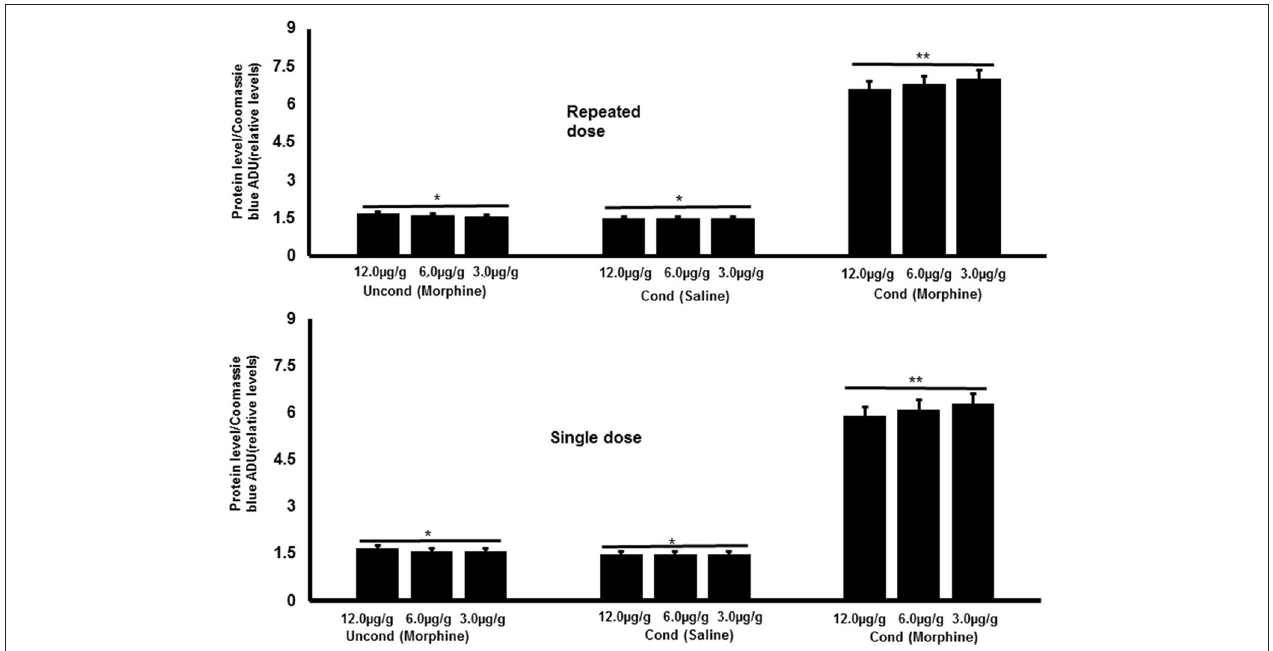
FIGURE 3 | The effect of morphine (3.0, 6.0, and 12.0 µ g/g doses) and different environmental treatments on the alteration of c-Fos protein expression for the single and repeated drug treatments regime. N = 7 for all treatment doses (3.0, 6.0, and 12.0 µ g/g) for each environmental treatment. Normalization was determined with signal intensities of c-Fos proteins to the gels stained with Coomassie blue as a ratio to produce relative abundance units (Dosimetry; ADU). Levels of c-Fos proteins were expressed as a ratio of ADU value to the whole protein in Coomassie blue-stained gels. For the single morphine treatment, there was a significant effect of the environment [ F (1, 54) = 90.23, P < 0.001] such that morphine conditioned environment significantly increased c-Fos (** P < 0.05) when compared with the effect of conditioned saline (* P < 0.05) or morphine unconditioned environment (* P < 0.05). The effect of the environment was also significant for the repeated treatment [ F (1, 54) = 50.25, P < 0.001], such that there was a significant effect of morphine conditioned-environment on the alteration of c-Fos expression (** P < 0.05) when compared with saline conditioned (* P < 0.05) or morphine unconditioned environment (* P < 0.05).